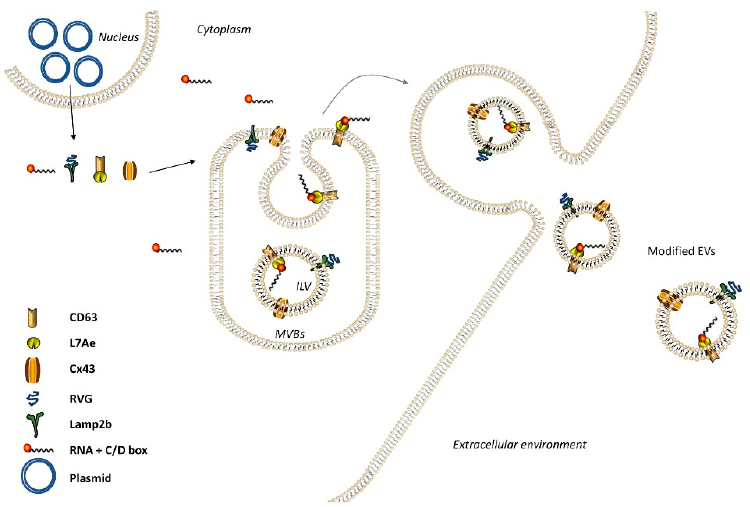
Figure 3. mRNA delivery by Exosomal transfer into cells (EXOtic). EV containing the RNA packaging device CD63-L7Ae (which can bind to the C / Dbox in the 3 (cid:48) UTR of any RNA structure), targeting module (RVG-Lamp2b to target CHRNA7), cytosolic delivery helper (Cx43 S368A), and mRNA (e.g., nluc-C / Dbox) e ffi ciently produced from EV donor cells. Engineered EVs will be delivered to target cells, expressing CHRNA7, with the help of